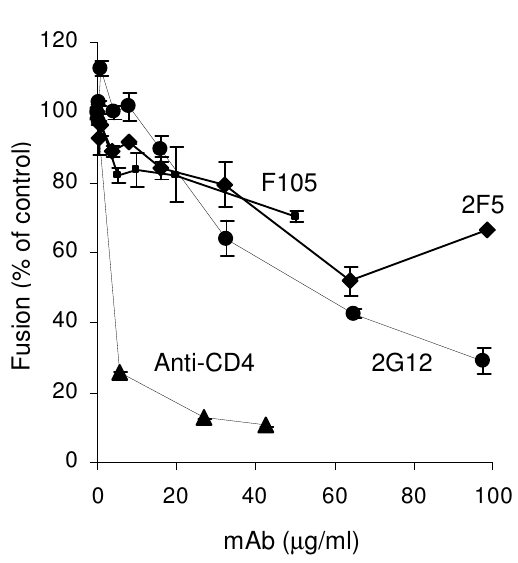
FIGURE 10 . Fusion inhibition obtained with anti-CD4, anti- gp41 (2F5), and two anti-gp120 (F105 and 2G12) monoclonal antibodies. Data are expressed as percent of fusion obtained in the absence of antibodies. (Reprinted from Huerta et al.[103]. Copyright 2005, with permission from the Society for General